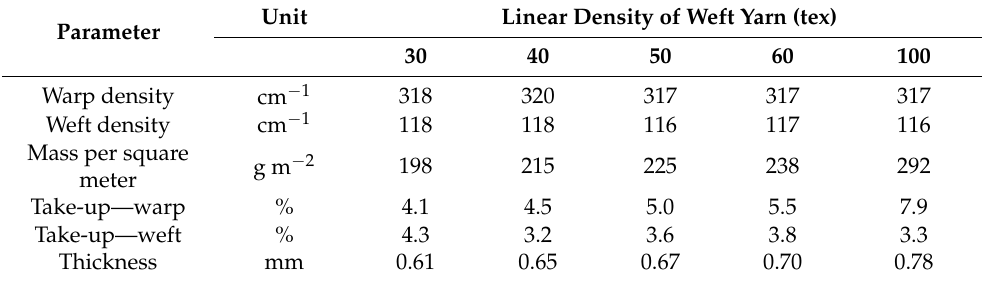
Table 1. The basic structural parameters of the investigated fabrics.